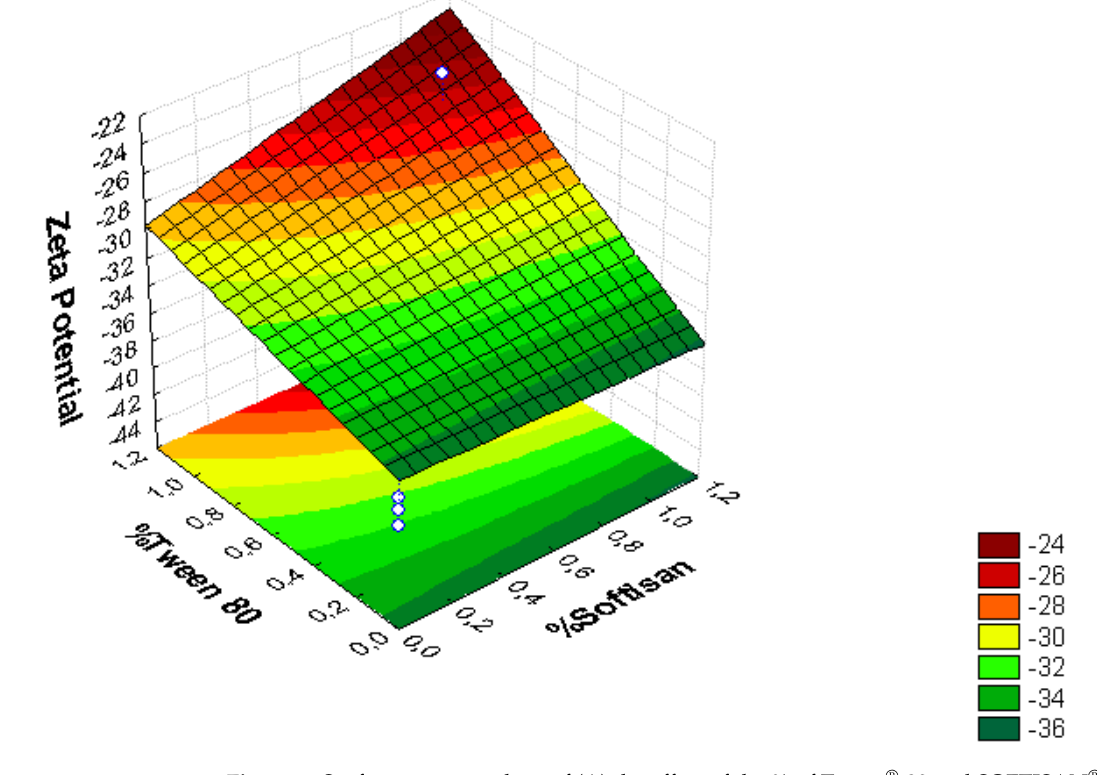
Figure 1. Surface response chart of (A) the effect of the % of Tween ® 80 and SOFTISAN ® 649 on ZP.